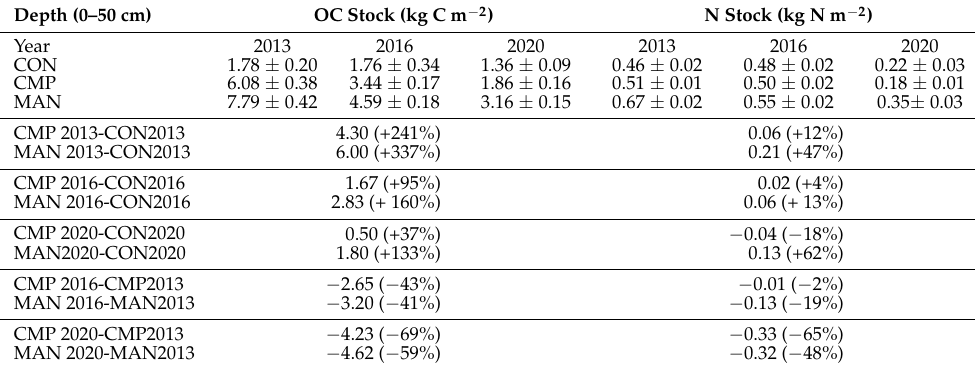
Table 4. Evolution of soil OC and N stocks between 2013 and 2016.